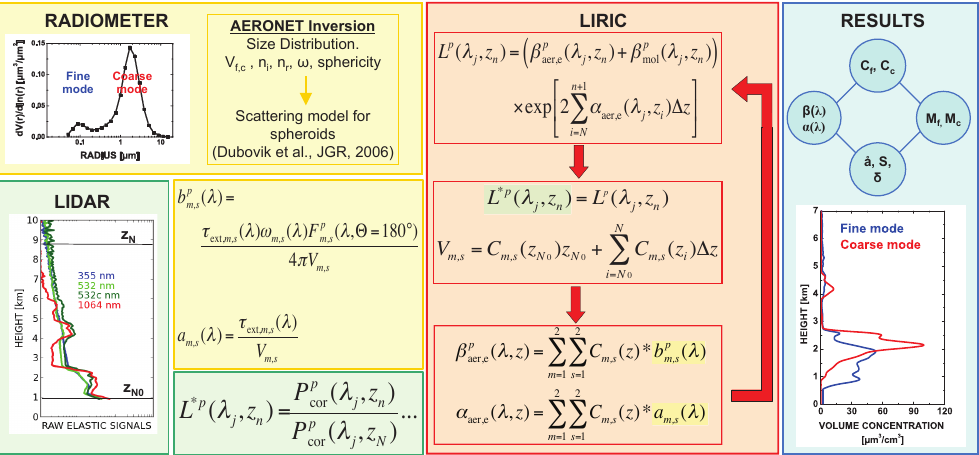
Fig. 1. Basic structure of LIRIC. Photometric information (radiometer, top yellow box) is used to retrieve height-independent (column) volume-specific backscatter and extinction coefficients b m,s and a m,s (center yellow box) for spherical ( s = 1) and non-spherical particles ( s = 2) of the fine mode ( m = f) and coarse mode ( m = c). A lidar signal term L (orange box, top) can be calculated with LIRIC by using profiles of backscatter and extinction coefficients (orange box, bottom) that, in turn, are calculated from the volume-specific coefficients b m,s and a m,s and profiles of particle volume concentration C m,s (z) . Deviations between the observed lidar signal term L ∗ (green box) and the LIRIC expression L are minimized in order to retrieve optimized C m,s (z) profiles (orange box, center). As a constraint, the integrals of the C m,s (z) profiles must match the respective column values V m,s as observed with AERONET photometer (orange box, center). LIRIC products (blue box) are profiles of particle optical properties (e.g., backscatter and extinction profiles, ˚Angstr¨om exponents, lidar and depolarization ratios) and microphysical properties (e.g., volume concentrations C f and C c as shown as profiles). The mass concentrations M f and M c for fine and coarse mode, respectively, are not LIRIC products.